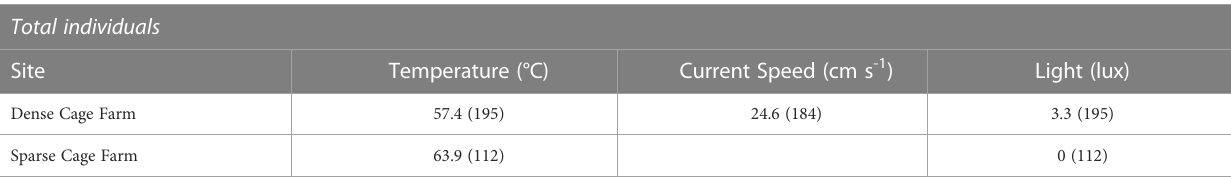
TABLE 4 Explanatory power (%) of running interval smooths using temperature, current speed, and light as predictors of fi sh abundance across sites in 2018 and